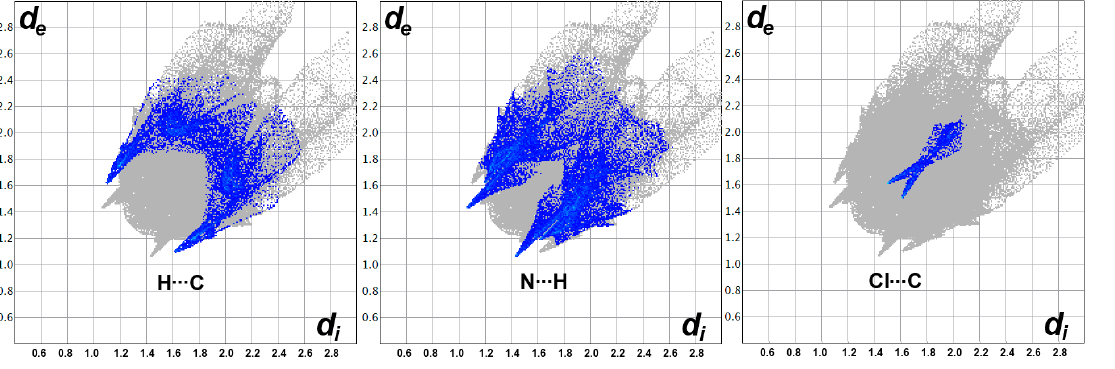
Figure 7. Decomposed fingerprint plots for the important interactions in the Zn(II) complex.